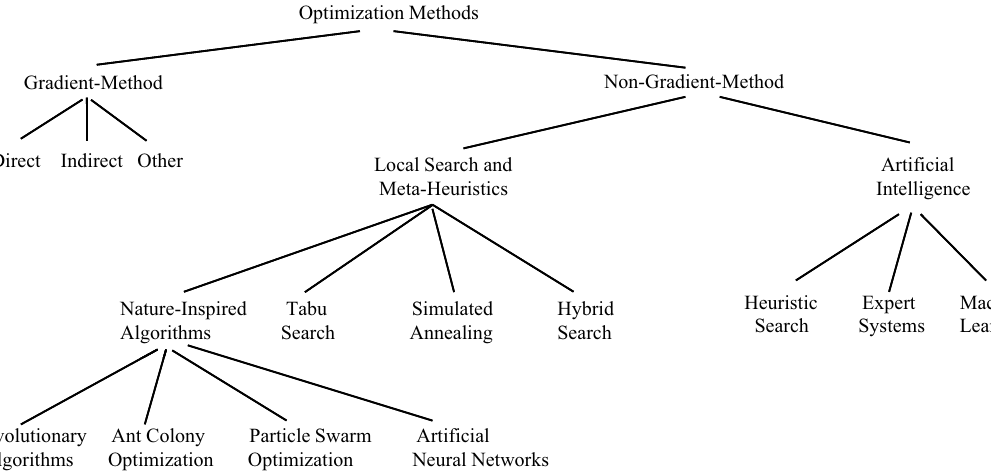
Fig. 3. Outline of optimization methods for engineering